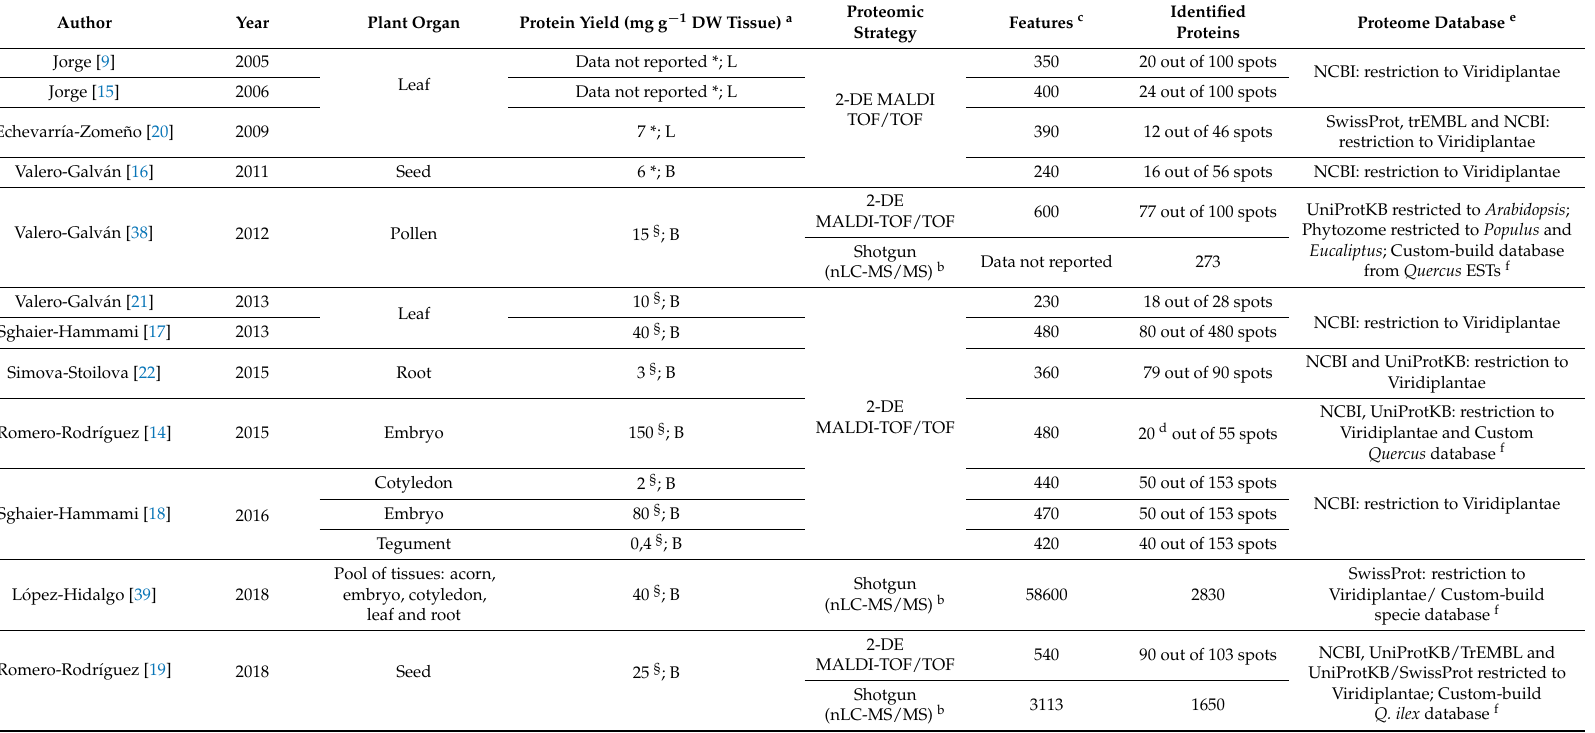
Table 1. Relevant results concerning proteomics research on Quercus ilex carried out by our